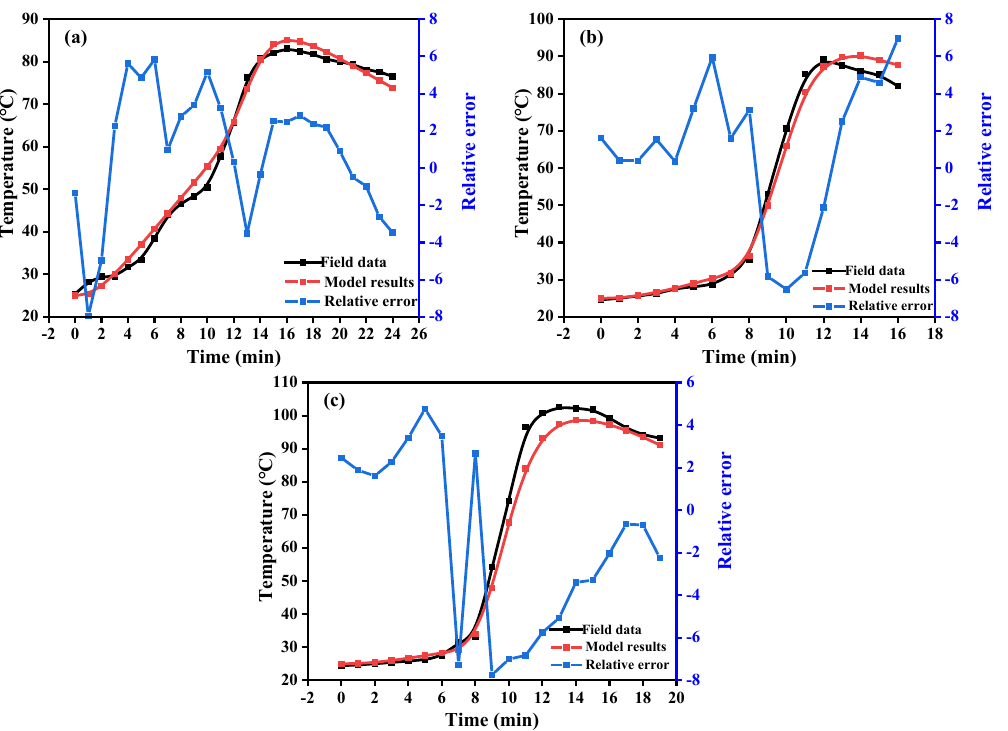
Figure 12. Numerical simulation and field test results: ( a ) JLS; ( b ) GHS; and ( c ) ZG.